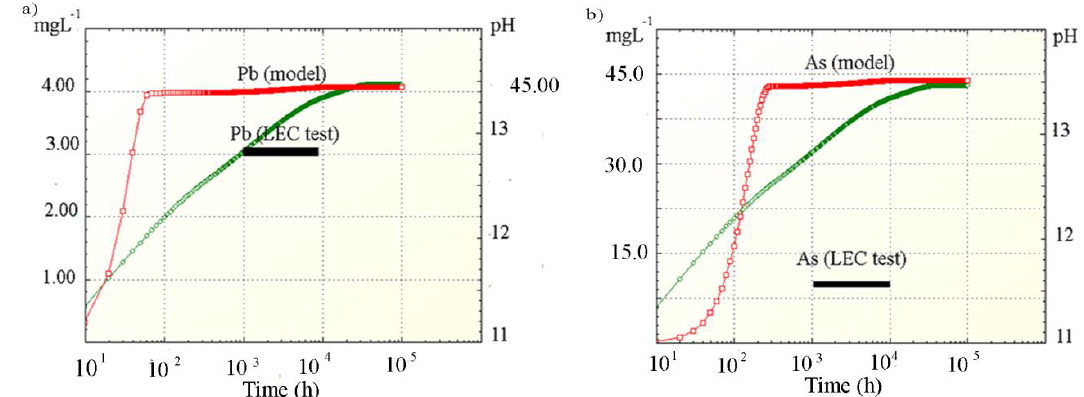
Figure 4. Simulated ( a ) Pb, and ( b ) As concentration profiles, pH values of leachates in the leaching process of the solidified productsS25 with distill water (PHREEQC program).